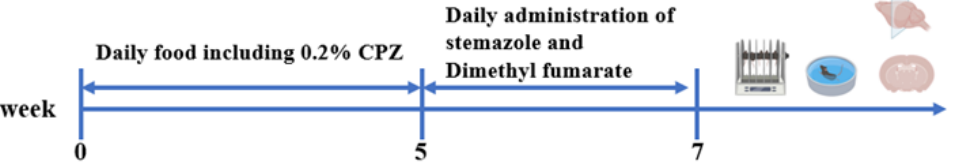
Figure 8. A diagram of the cuprizone-induced demyelination model and the administration of stemazole.